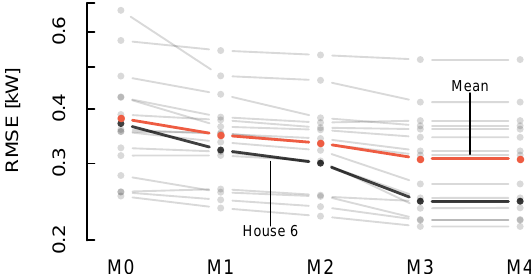
Figure 2. Slope chart of root mean squared error (RMSE) of models M0–M4 tested on 16 houses. The RMSE is based on a 20% cross-validation data set. Notice that the logarithmic scale is used, meaning that the slopes between the points indicates the relative change in RMSE. The corresponding RMSE for each house is indicated as a grey or black dot. The red line indicates the mean RMSE across all 16 houses and the black line indicates House 6 which we will study in details. Notice that the RMSE is plotted on a logarithmic scale, i.e., the slopes of the lines between the points express the relative change in model